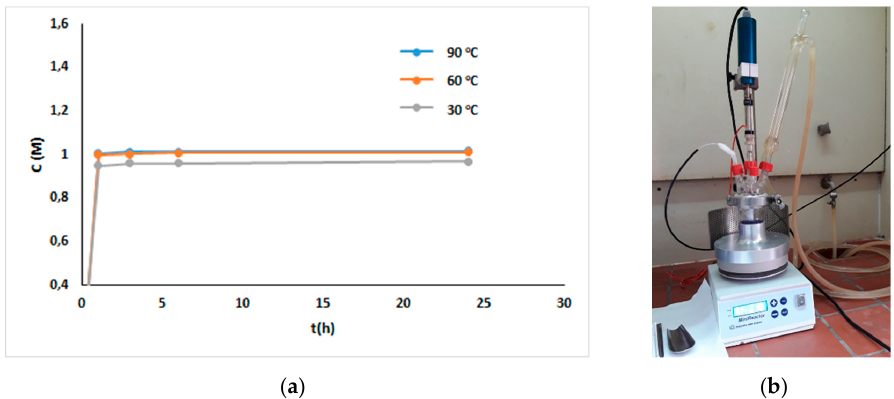
Figure 1. ( a ) Nd concentration measured by inductively coupled plasma optical emission spectrometer (ICP-OES) for the solutions prepared and ( b ) the mini reactor used for the dissolution experiments.